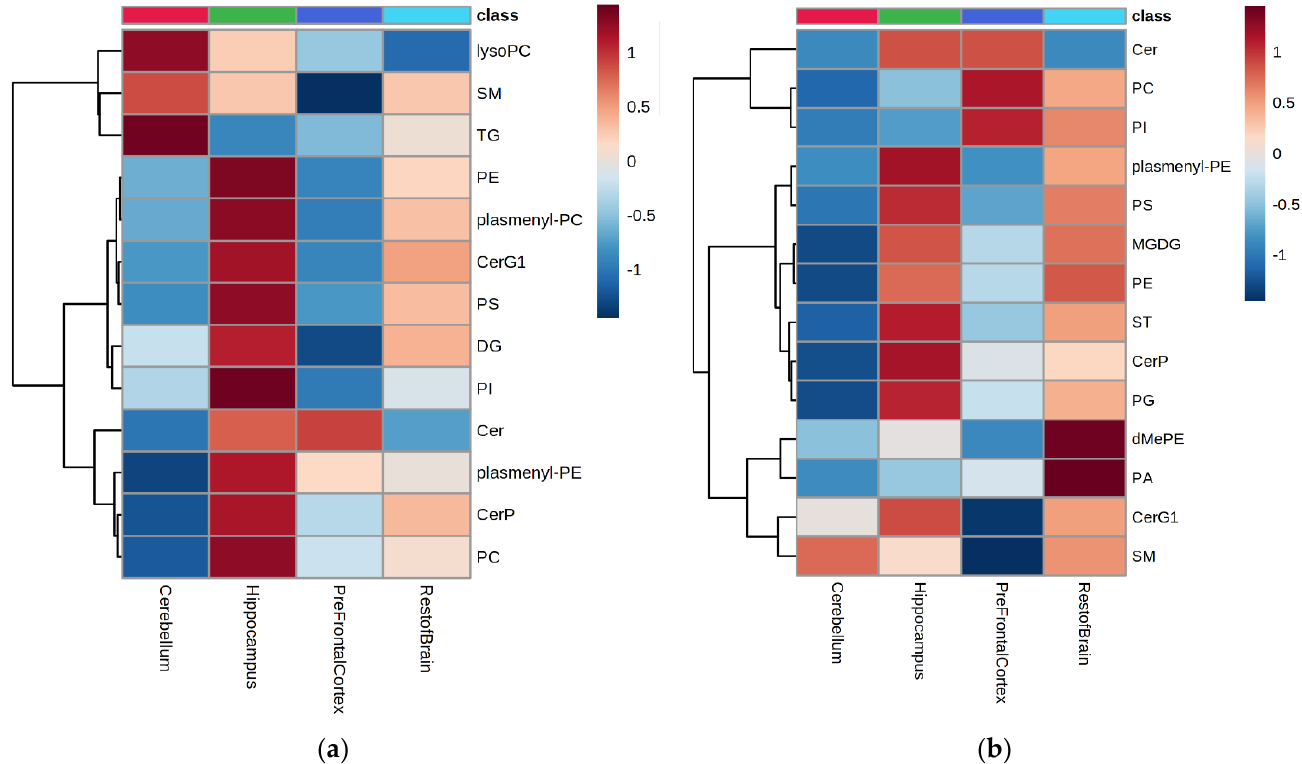
Figure 1. Heatmap of mean total lipid abundances at the lipid class level for four brain regions (cerebellum, hippocampus, prefrontal cortex, and the rest of the brain) in positive mode ( a ) and negative mode ( b ), regardless of intervention (n = 23 animals). Average of sum peak area data log10 normalized and auto-scaled for each lipid class, red = high abundance and blue = low abundance levels. Cer = ceramide, CerG1 = monoglycosylceramide, CerP = ceramide phosphate, DG = diacylglyceride, lysoPC = lysophosphatidylcholine, PA = phosphatidic acid, PC = phosphatidylcholine, PE = phos- phatidylethanolamine, PG = phosphatidylglycerol, PI = phosphatidylinositol, PS = phosphatidylser- ine, SM = sphingomyelin, ST = sterol ester, TG =